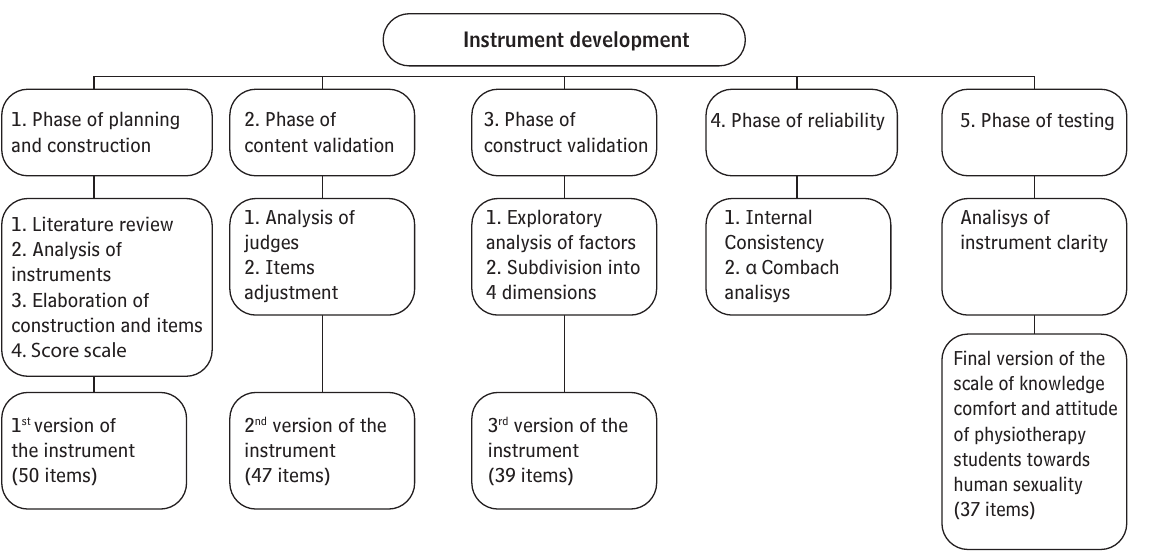
Figure 1 - Instrument development